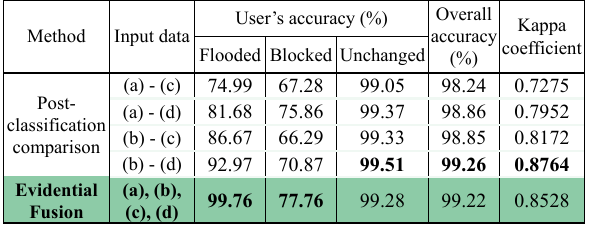
Table 3. Performances of the landslide barrier lake detection with different methods and input